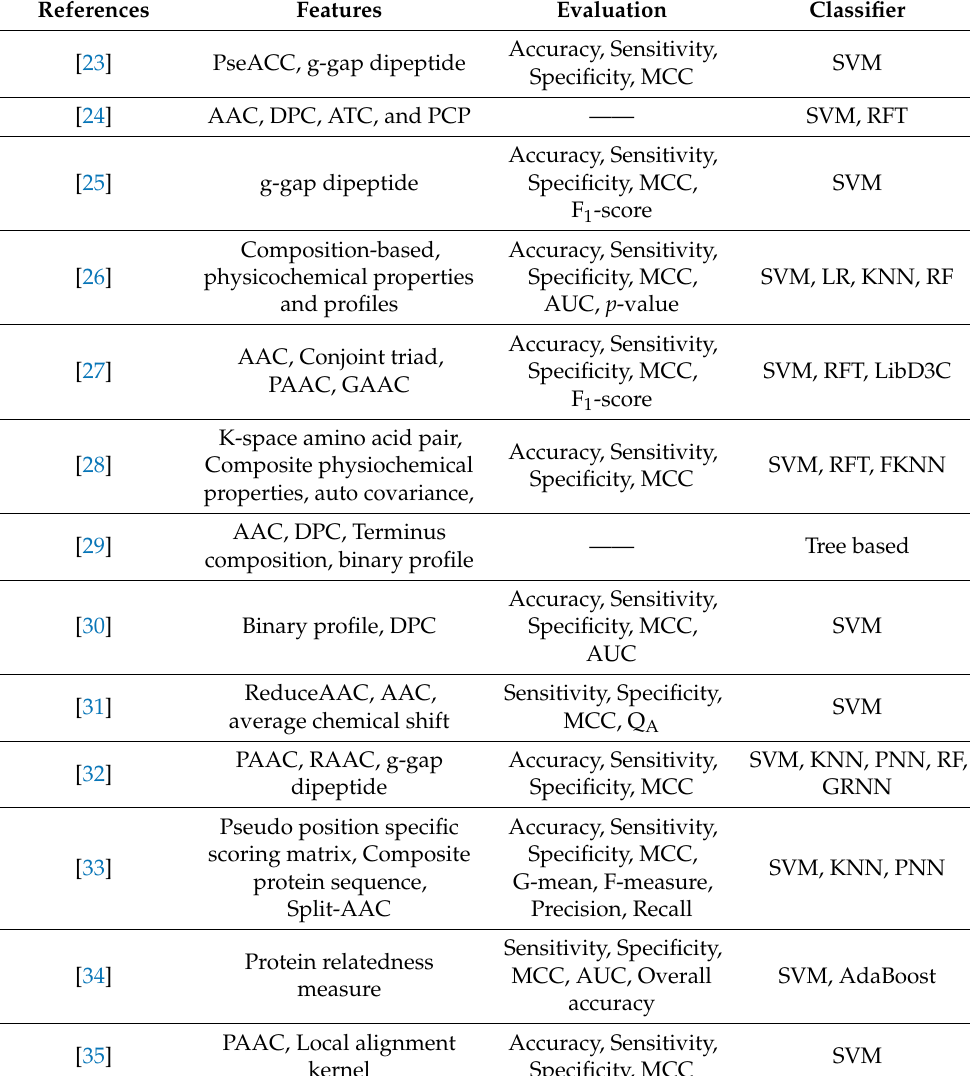
Table 1. Existing approaches for the prediction of ACPs and NACPs using ML